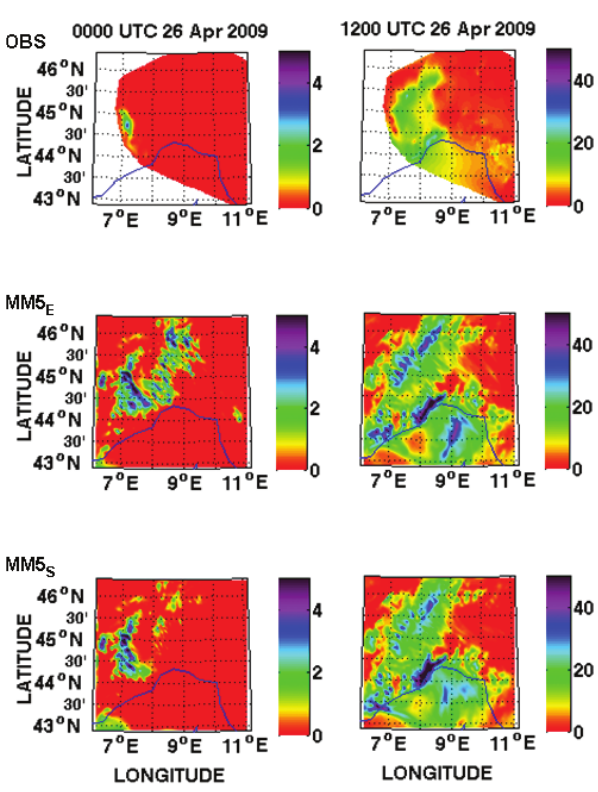
Fig. 8. 6h accumulated precipitation (mm) on 26 April in domain 3 at 00:00UTC (left panel) and 12:00UTC (right